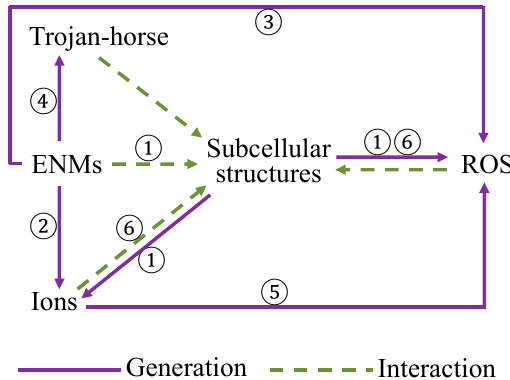
Figure 2. Schematic illustration of possible mechanisms of metallic ENMs triggering nanotoxicity. (1) ENMs directly in contact with subcellular structures, which can promote the release of ions and ROS generation; (2) ENMs releasing ions; (3) ENM contact-mediated ROS generation; (4) Trojan-horse mechanism triggered by ENMs; (5) released ions increasing the formation of ROS; (6) ion-dependent interactions that may lead to cellular damage or trigger ROS formation.